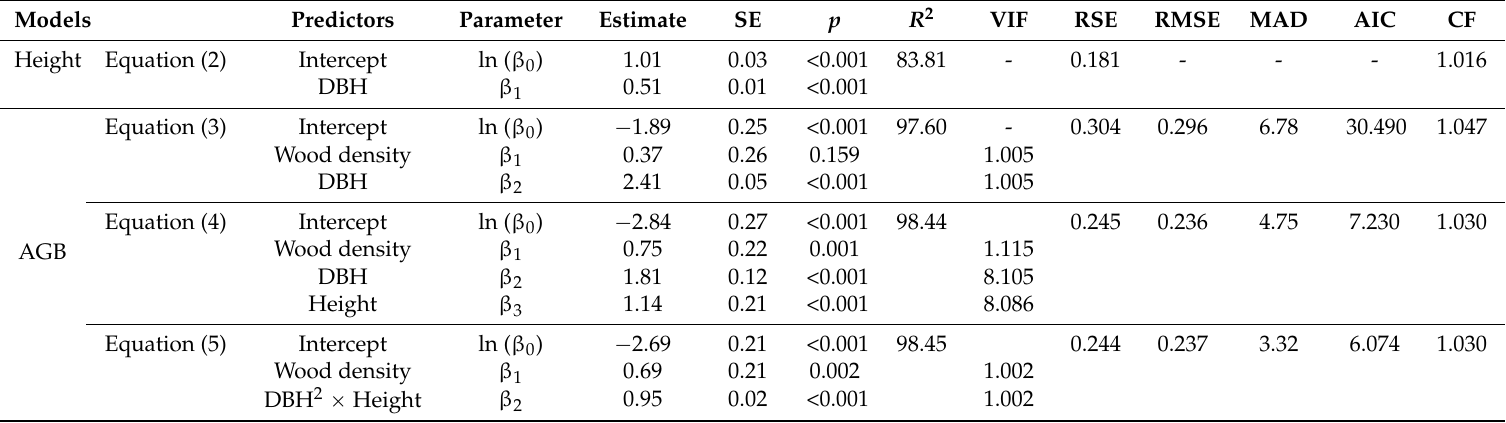
Table 3. Multispecies DBH-height and aboveground biomass (AGB) equations with coefficient estimates and statistic fits. SE: Standard Error; R 2 : Adjusted R Square; VIF: Variance Inflation Factor; RSE: Residual Standard Error; RMSE: Root Mean Squared Error; MAD: Mean Absolute Deviation; AIC: Akaike Information Criterion and CF: Correction